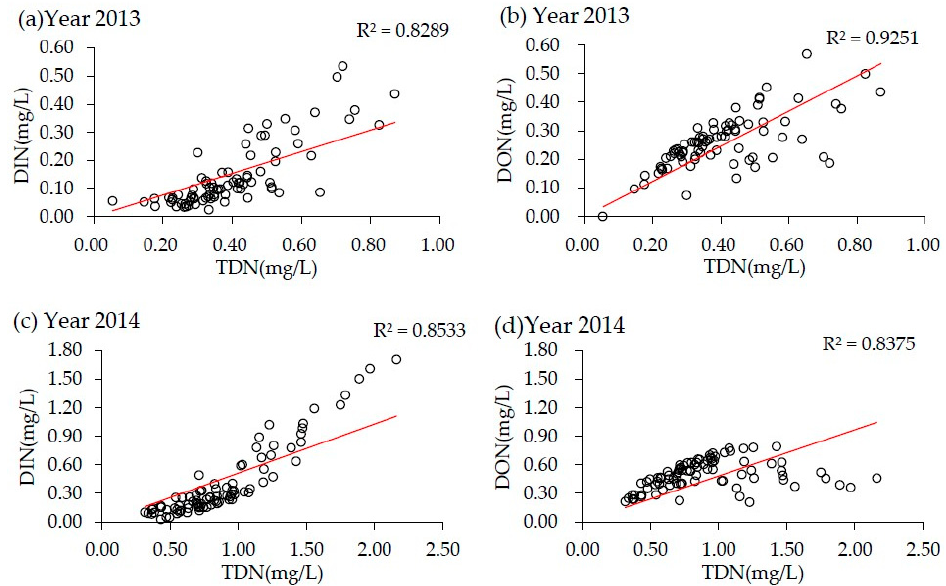
Figure 10. The relationships of DIN–TDN and DON–TDN at 20 stations from June 2013 to August 2014. Table 4. Summary of the values of DIN/TDN and DON/TDN. Period DIN/TDN